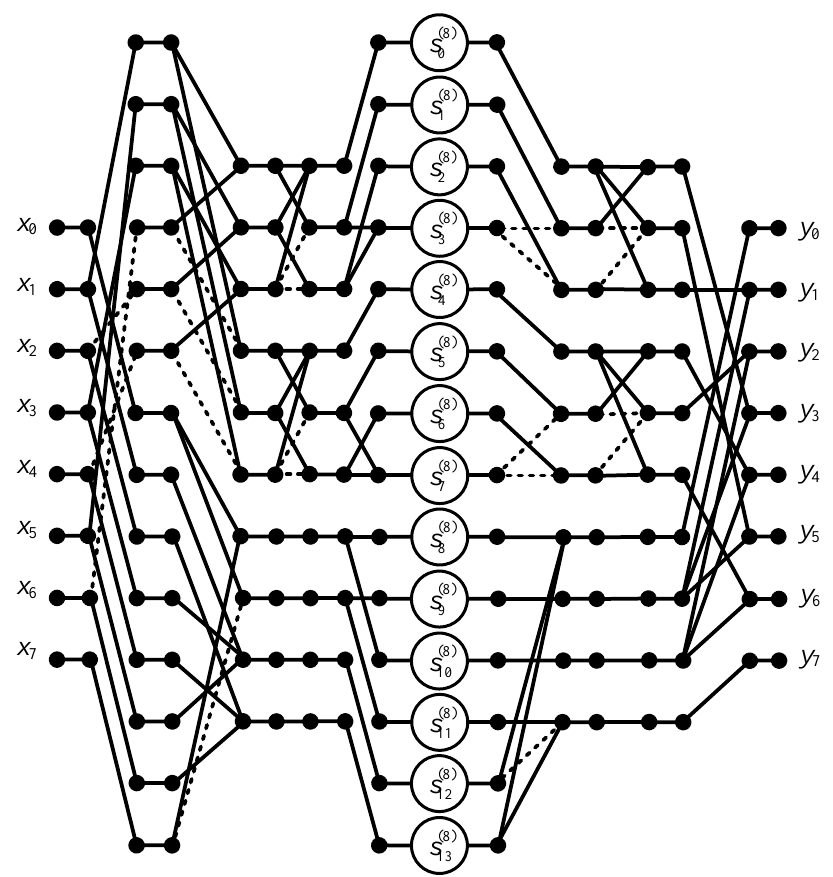
Figure 7. Signal flow graph of the algorithm for computing the 8-point